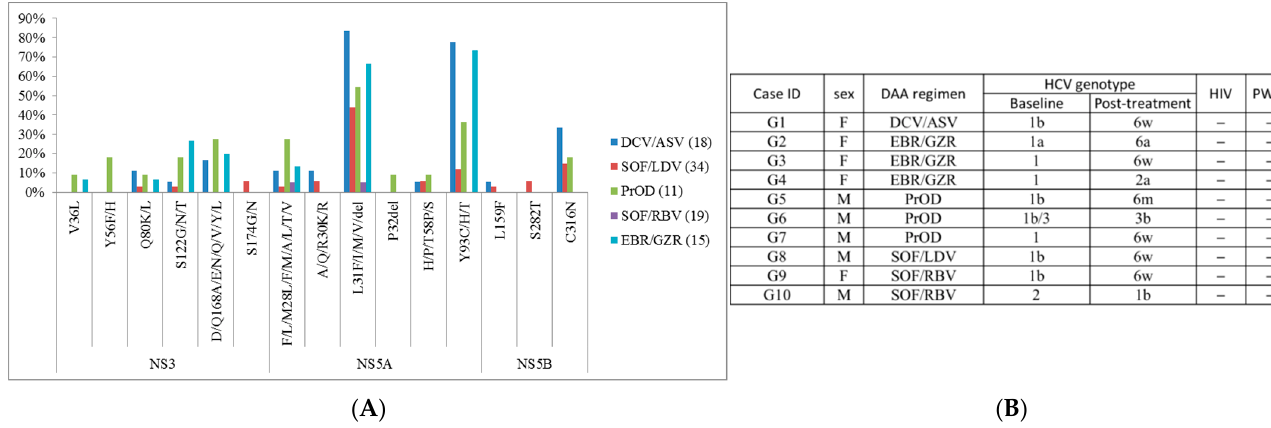
Figure 2. Summary of ( A ) RASs in patients with genotype ‐ specific DAA treatment and ( B ) cases with different baseline/post ‐ treatment HCV genotype. ” − “, negative.